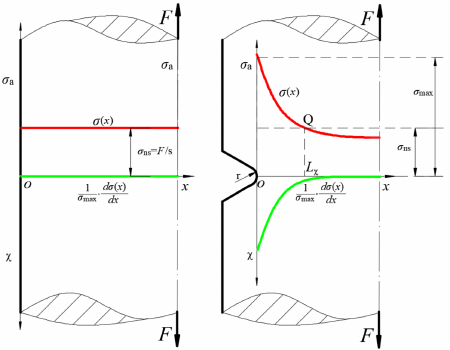
Figure 6. Definition of the range of influence of the stress